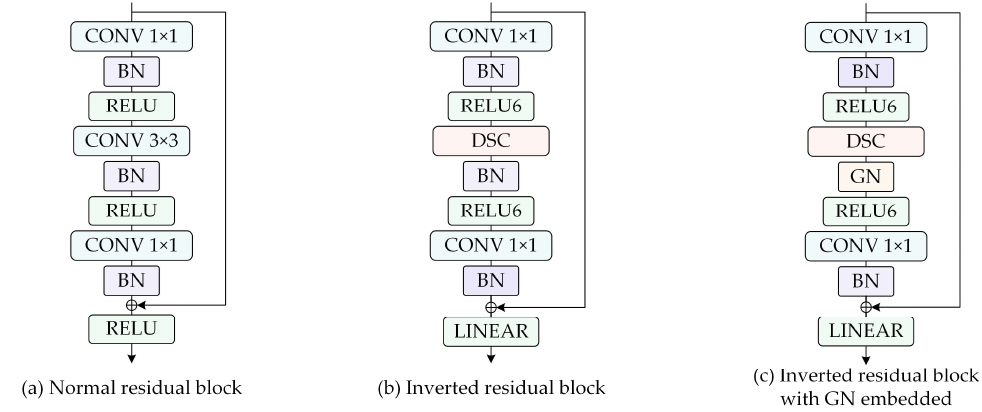
Figure 3. Schematic diagram of ( a ) the normal residual block, ( b ) the inverted residual block, and ( c ) the inverted residual block with GN embedded.